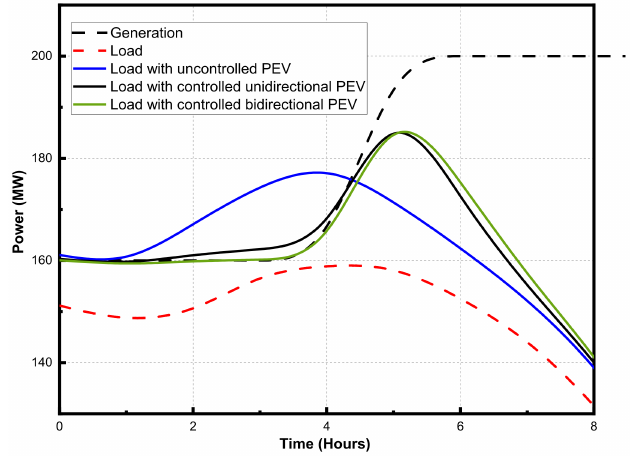
Figure 7. Load consumption for one scenario during an interruption period with 40% BEV penetration and 7.2 kW charger rating.